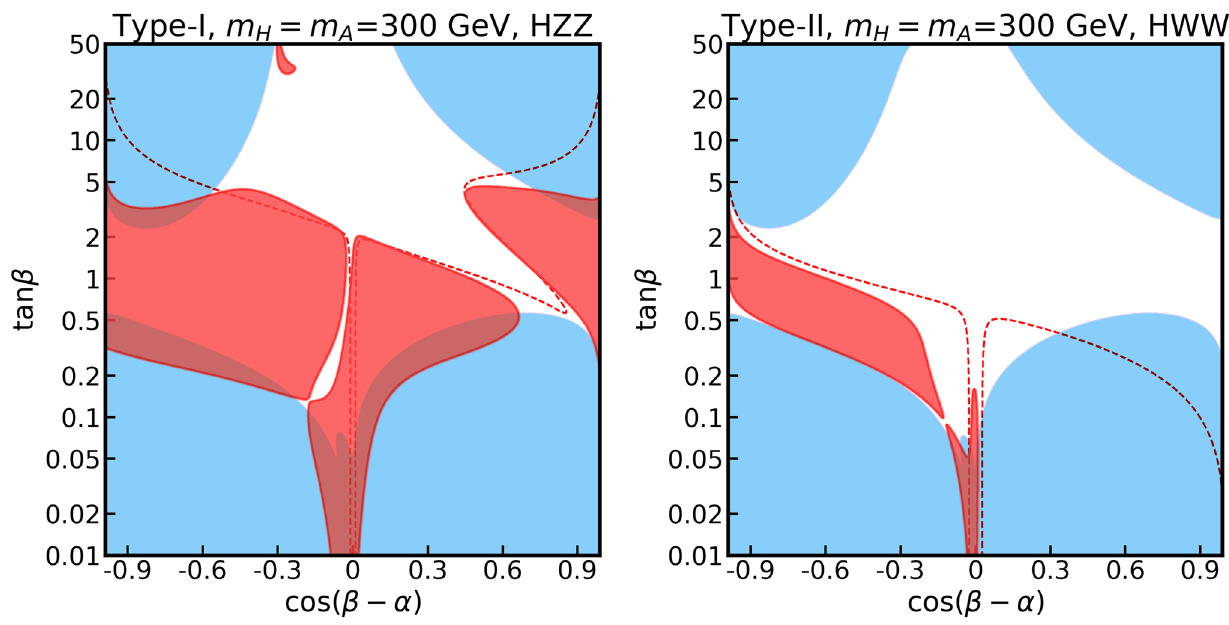
Fig. 4 Regions in the cos (β − α) -tan β plane excluded by experimen- tal results in the H → V V channel, with assumed degenerate heavy Higgs masses of 300 GeV. The red dashed lines in the figures represent the tree-level constrained regions, while the red shadow regions are excluded by the one-loop-level results. In the case of diboson decay,